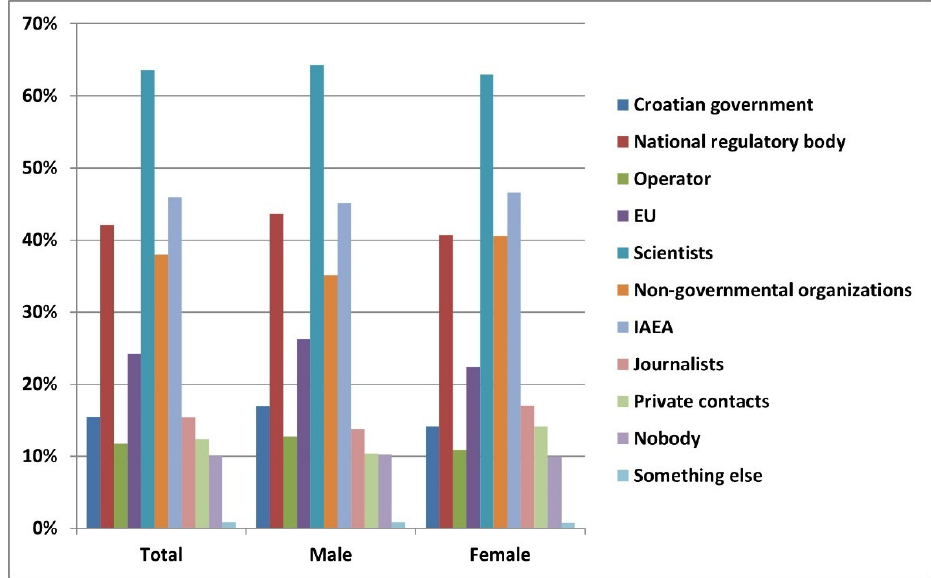
Figure 12. Trustworthy sources of information.